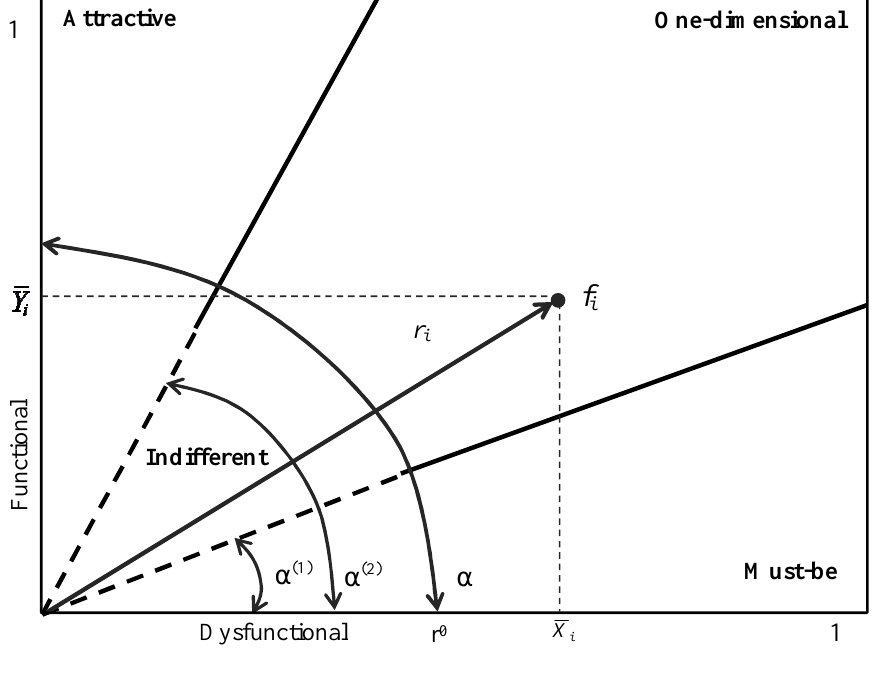
Figure 2 –The analytical Kano’s model (Lee et al.,